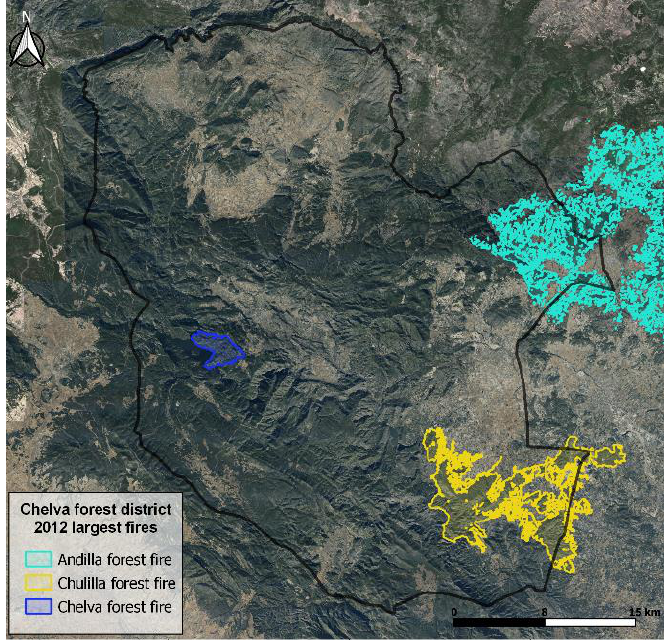
Figure 2. Location of the largest fires in Chelva forest district in 2012.